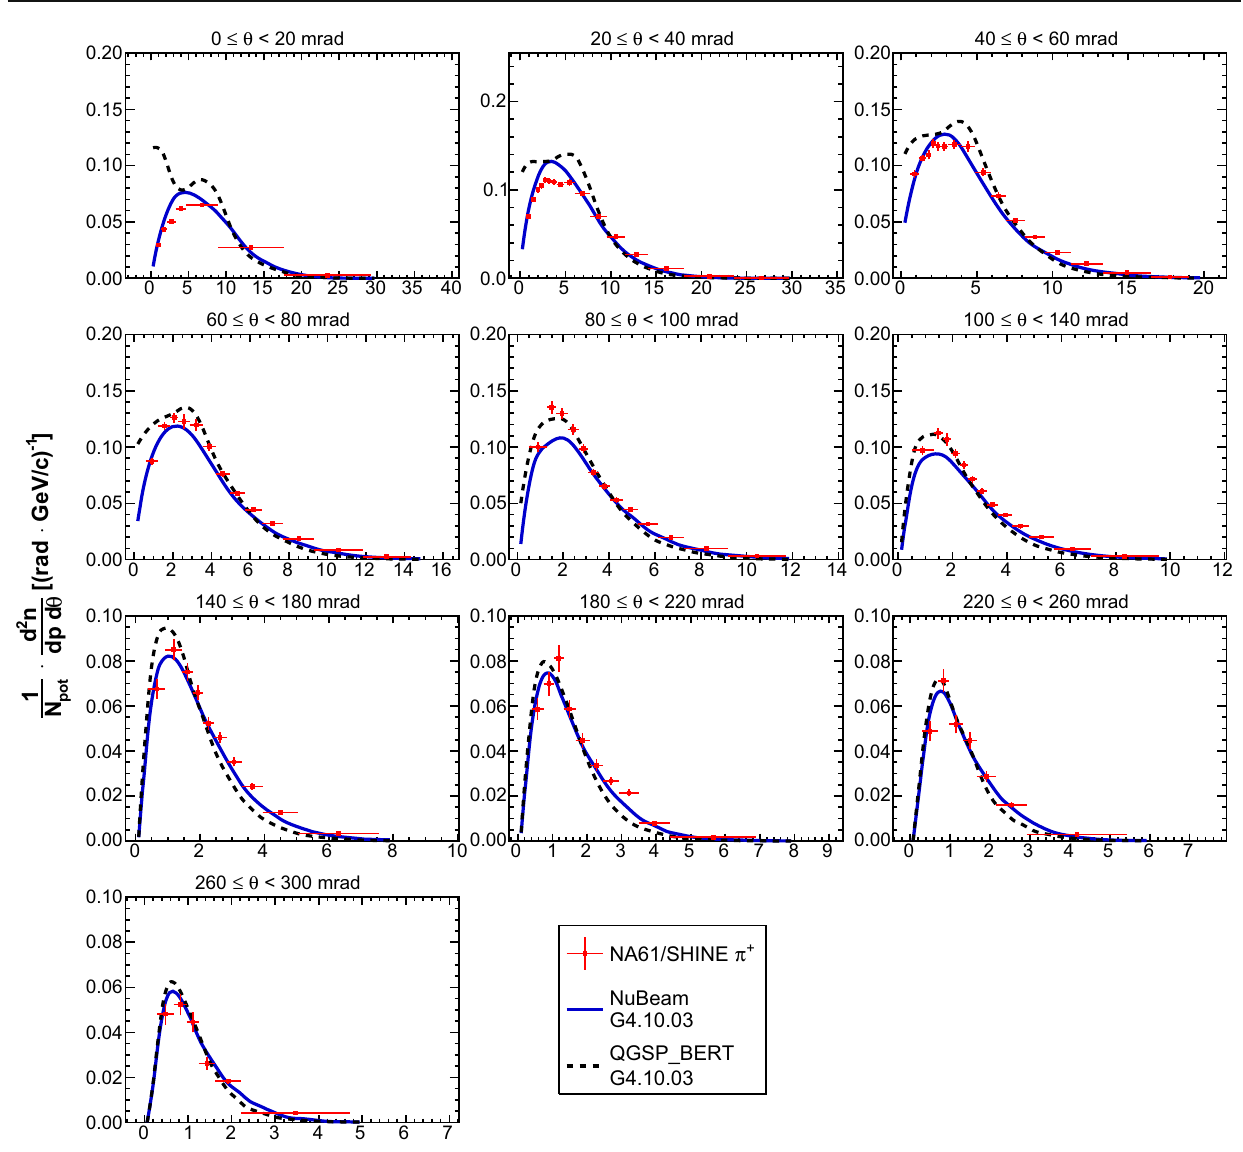
QGSP_BERT (blue) physics lists from Geant4.10 .03 [27,28] are